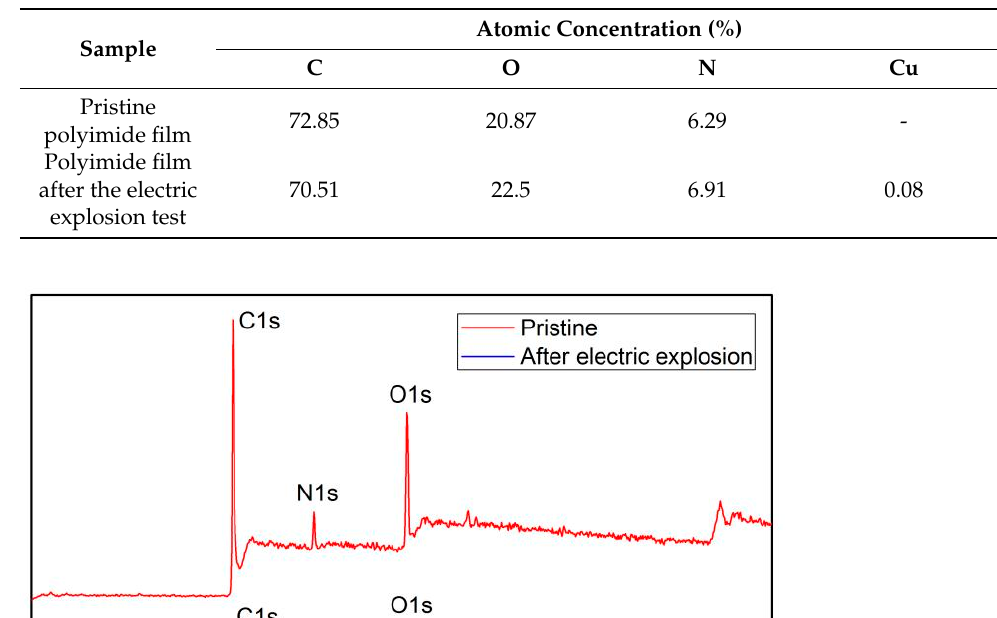
Table 2. The atomic ratio of C, O, and N in pristine polyimide film and the sample after the electric explosion test.